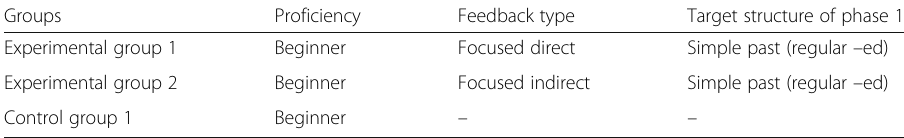
Table 5 Participating groups and target